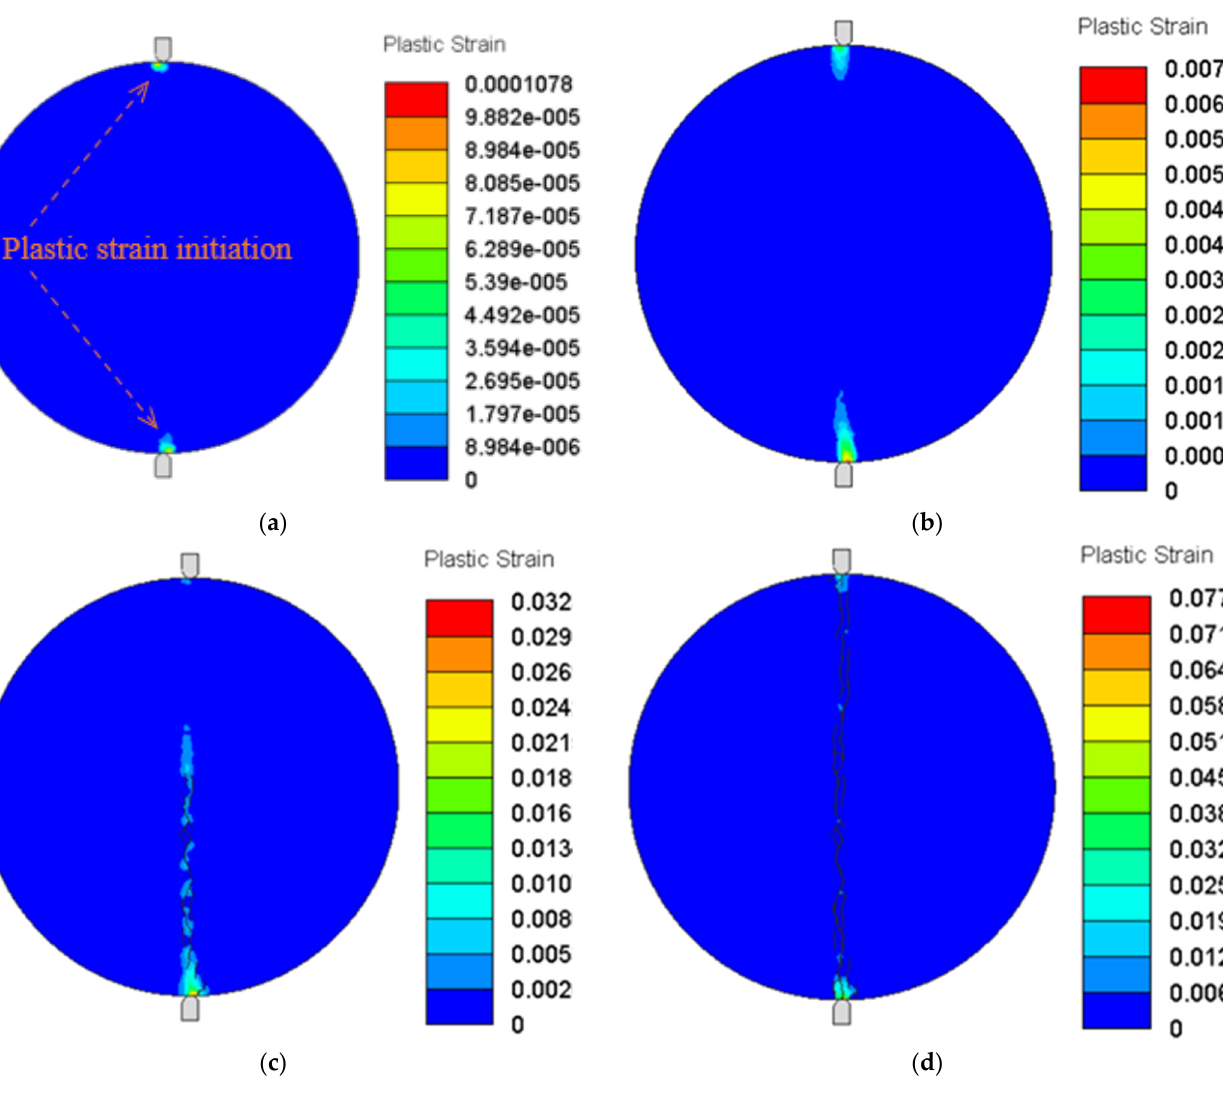
Figure 15. The plastic strain evolution with load for the Type I testing: ( a ) 6.8 kN, ( b ) 20.6 kN, ( c ) 19.2 kN (post − peak), ( d ) 4.2 kN (post − peak).